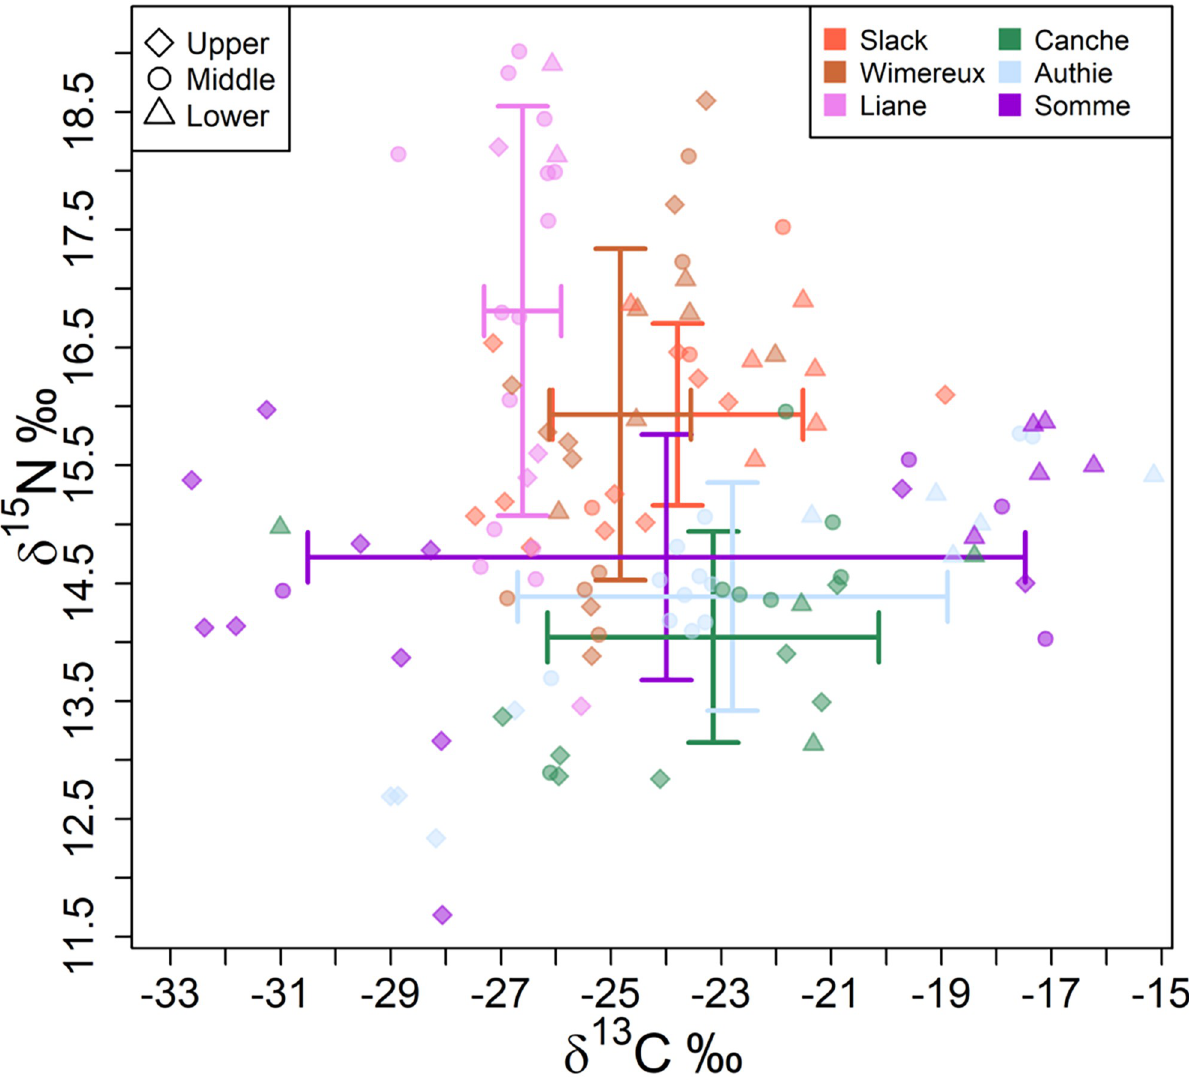
Fig 3. δ 13 C and δ 15 N values (‰) of European eels collected along salinity gradient (i.e. lower, middle and upper) in the six estuaries. The mean ± standard deviation of the δ 13 C and δ 15 N values for the six estuaries is also